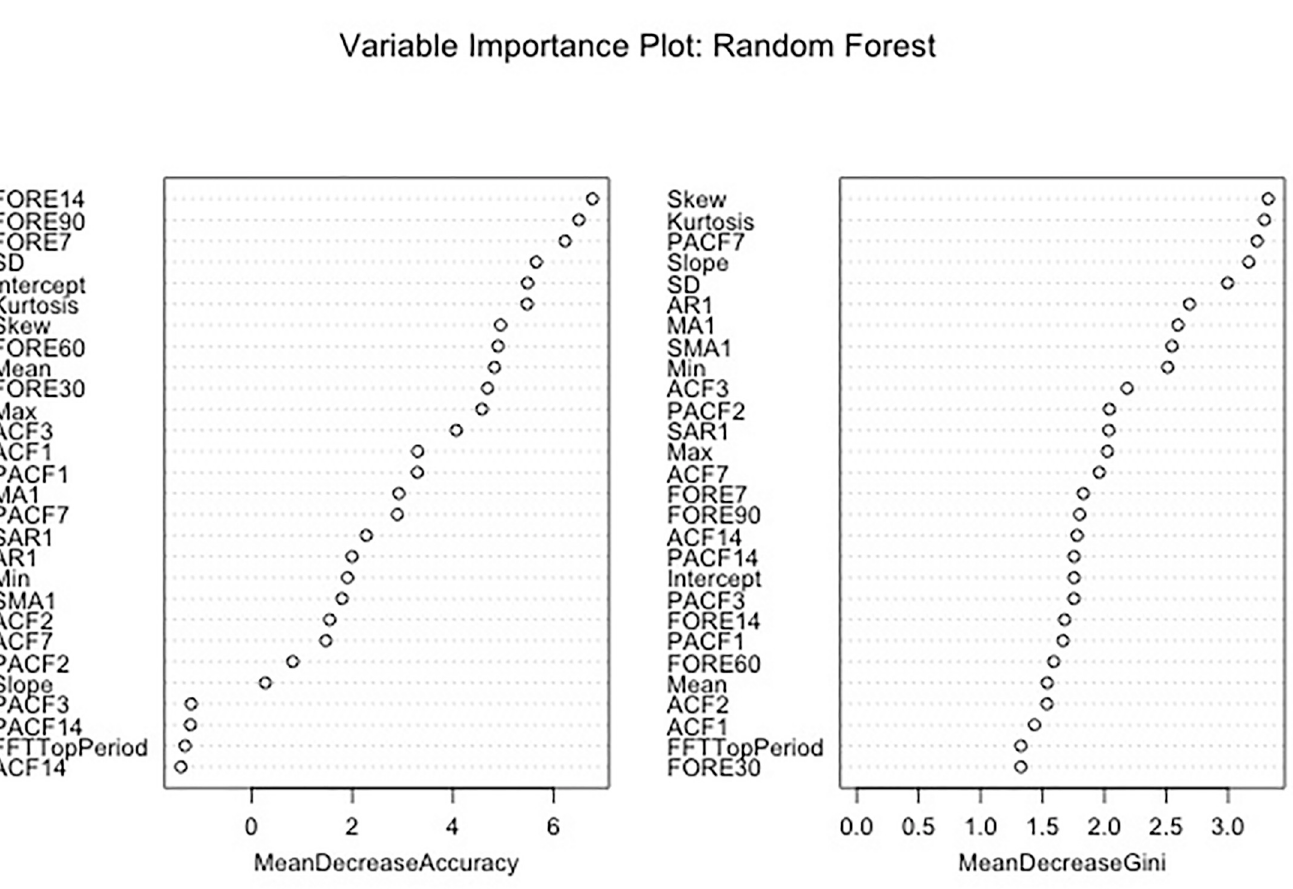
Fig 3. Variable importance plot. From random forest model.